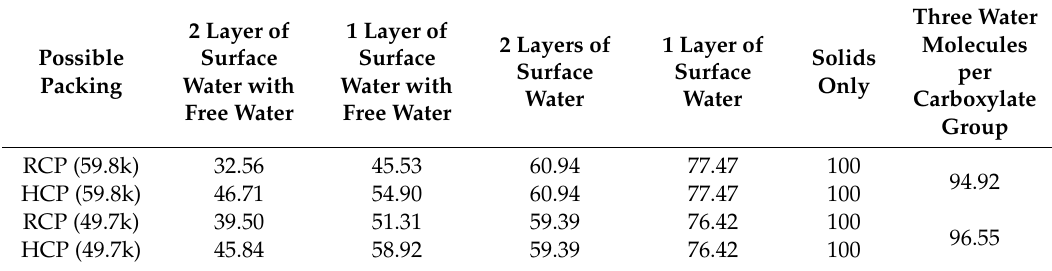
Table 5. Percent solids for CUP Polymer 2&6 for HCP and